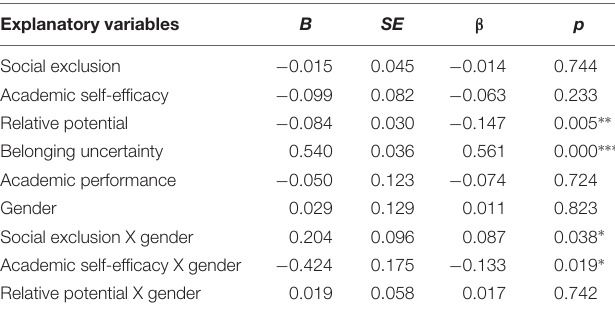
TABLE 3 | Multiple linear regression for variables at T1 predicting belonging uncertainty at